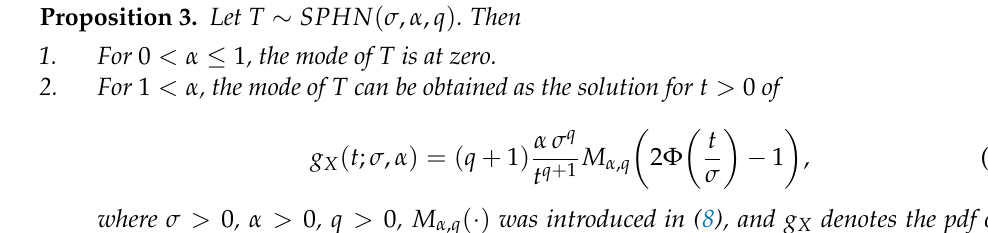
Figure 2 for σ = 1 and α = 2 fixed and several values of q , q corresponds to the PHN ( σ , α ) ). On the other hand, plots for the cdf, survival and hazard rate function of SPHN model, taken σ = 1, for 0 < α < 1 ( α = 0.8), and α = 1, by considering increasing values of q are given in Appendix A.1 and Appendix A.2,